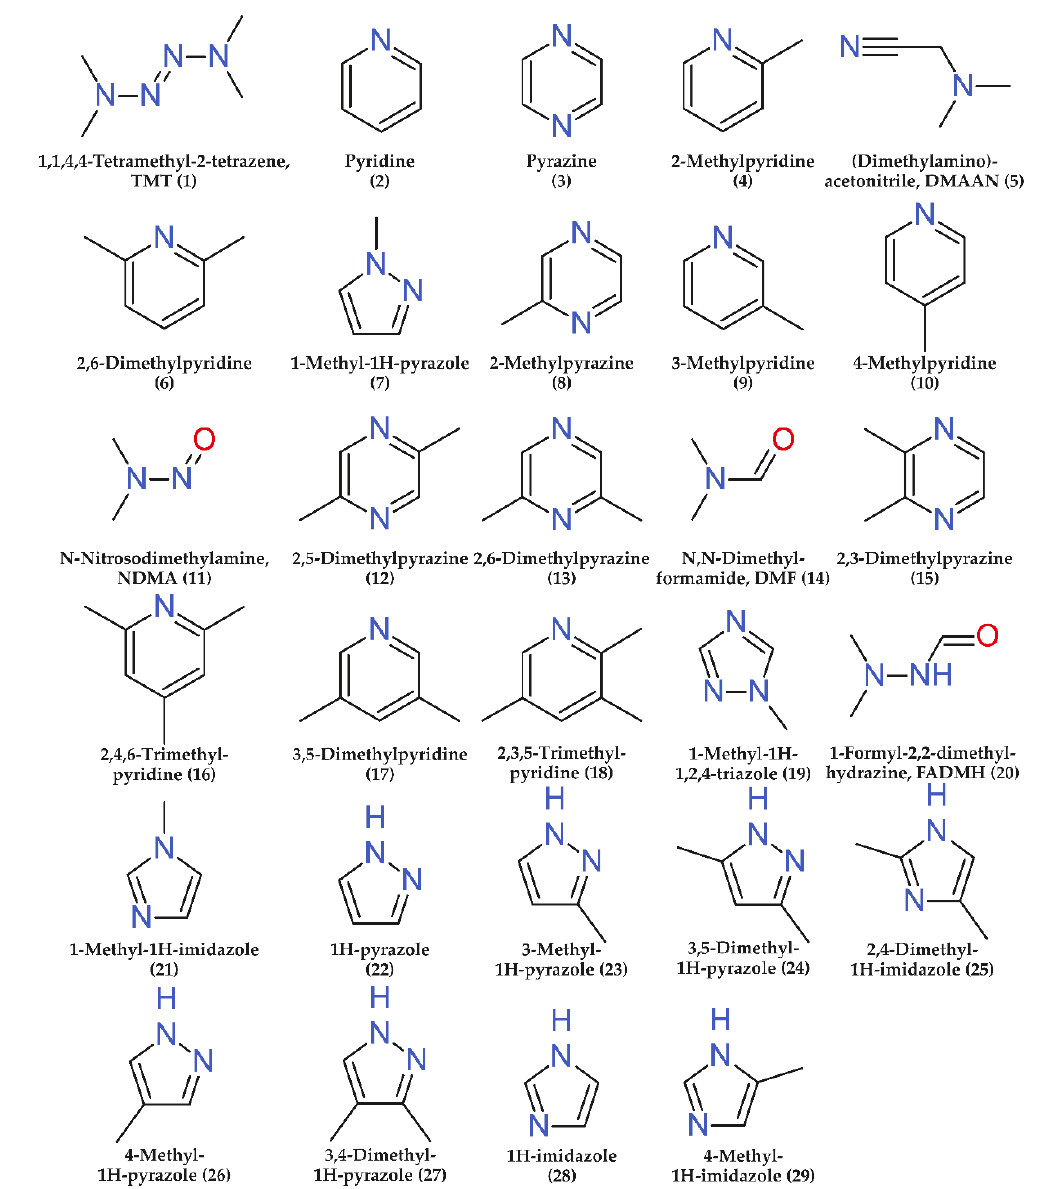
Figure 1. Structural formulas of the target analytes (numbers in parenthesis correspond to the serial numbers of analytes in Figure 2 and tables).